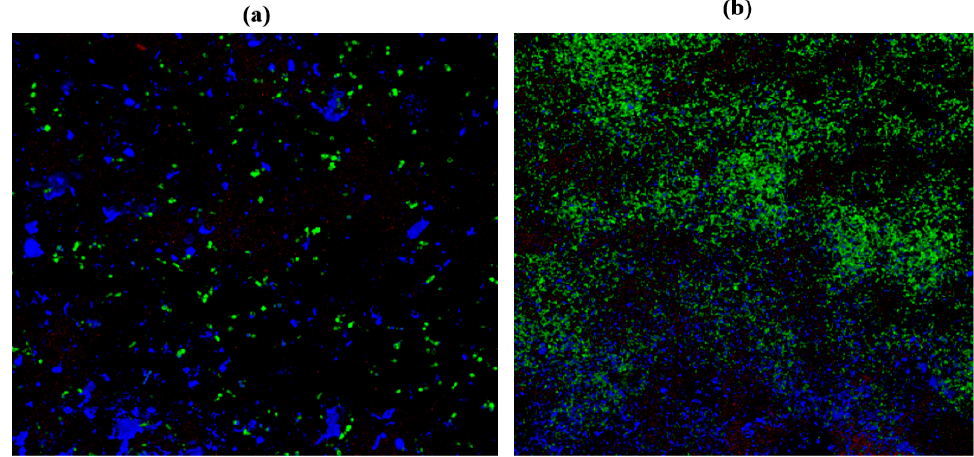
Figure 9. 3D resolution images of whole AGE ‐ treated (1.25 mg) E. coli ATCC 39936 using CLSM at